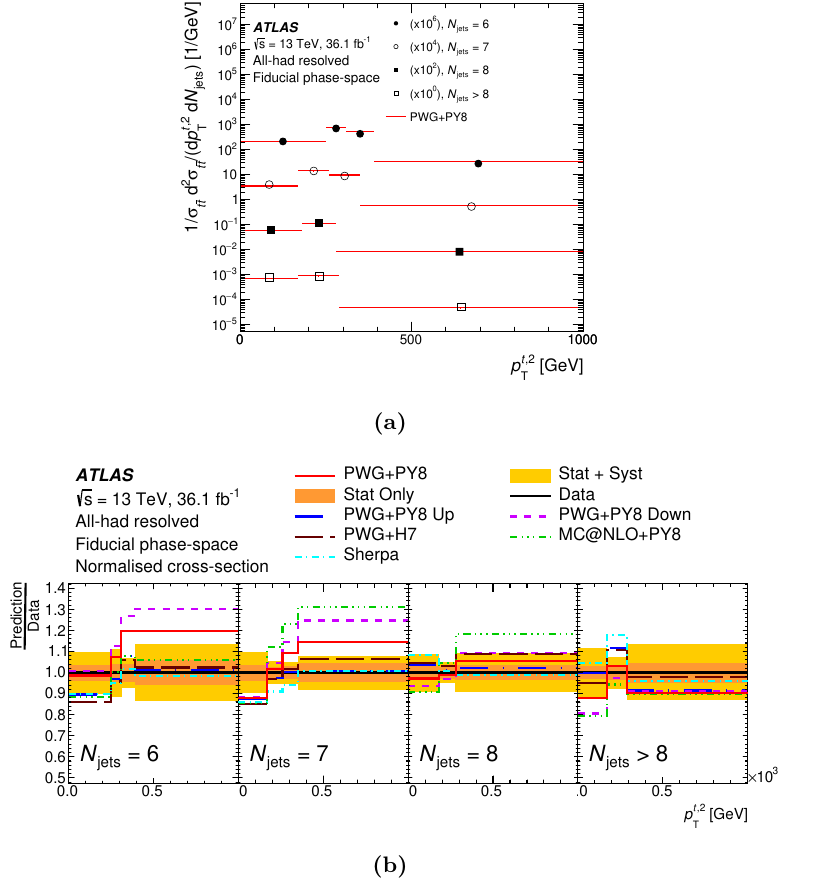
Figure 15 . Particle-level double-differential normalised cross-section (a) as a function of the sub- leading top-quark transverse momentum p t, 2 nominal Powheg+Pythia 8 prediction without uncertainties. Data points are placed at the centre of each bin. Different markers are used to distinguish the four bins in N on the horizontal axis. The ratio (b) of the measured cross-section to different MC predictions. Uncertainties are shown by the shaded